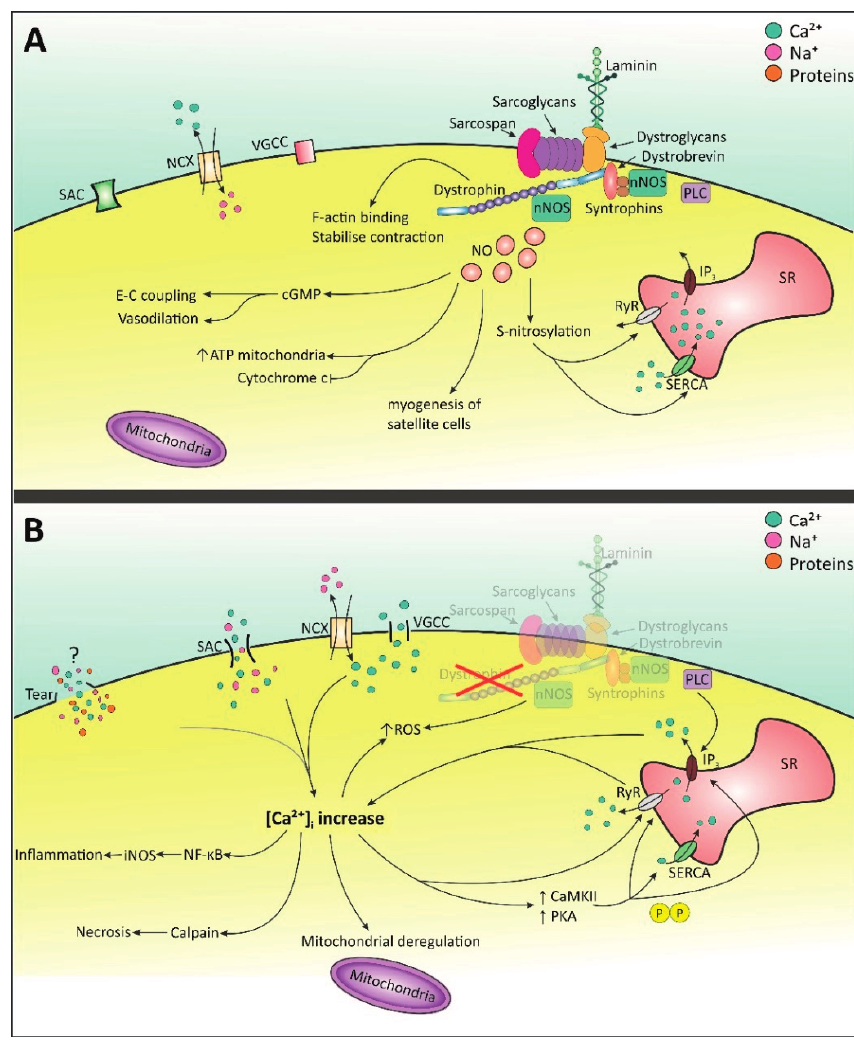
Figure 1. Molecular pathways involving Ca 2+ and NO signaling in healthy and dystrophic cell. ( A ) Dystrophin present: Ca 2+ is balanced by SACs, NCX and VGCC. nNOS is activated by Ca 2+ -dependent calmodulin [40–42]. NO is produced which is involved in many processes including normal E-C coupling, and S-nitrosylation of SERCA and RyR [25,40,42,43]. Upon E-C coupling, [Ca 2+ ] i rises via opening of RyR and IP 3 receptor. When the stimulus stops, intracellular Ca 2+ returns to normal via SERCA and other cell membrane Ca 2+ -permeable channels. ( B ) Dystrophin absent: membrane tears, SACs, NCX and VGCC increase intracellular Ca 2+ [28,35,36,38,44,45]. Elevated Ca 2+ increases CaMKII and PKA which hyper-phosphorylate Ca 2+ channels on the SR [31–33]. SERCA levels may decrease and RyR becomes sensitive to Ca 2+ [31,32,46–48]. Mis-localization of nNOS disrupts NO signaling and function [49,50]. This combined with raised Ca 2+ increases ROS production [28,51]. Increased [Ca 2+ ] i elicits multiple detrimental events [24,30]. SACs: stretched-activated channels; NCX: Na + -Ca 2+ exchanger; VGCC: Voltage-gated Ca 2+ channels; nNOS: neuronal nitric oxide synthase; SERCA: Sarcoplasmic/endoplasmic reticulum Ca 2+ -ATPase; RyR: ryanodine receptor; NO: nitric oxide; IP 3 : inositol 1,4,5-triphosphate; SR: sarcoplasmic reticulum; CaMKII: calmodulin-kinase II; PKA: protein kinase